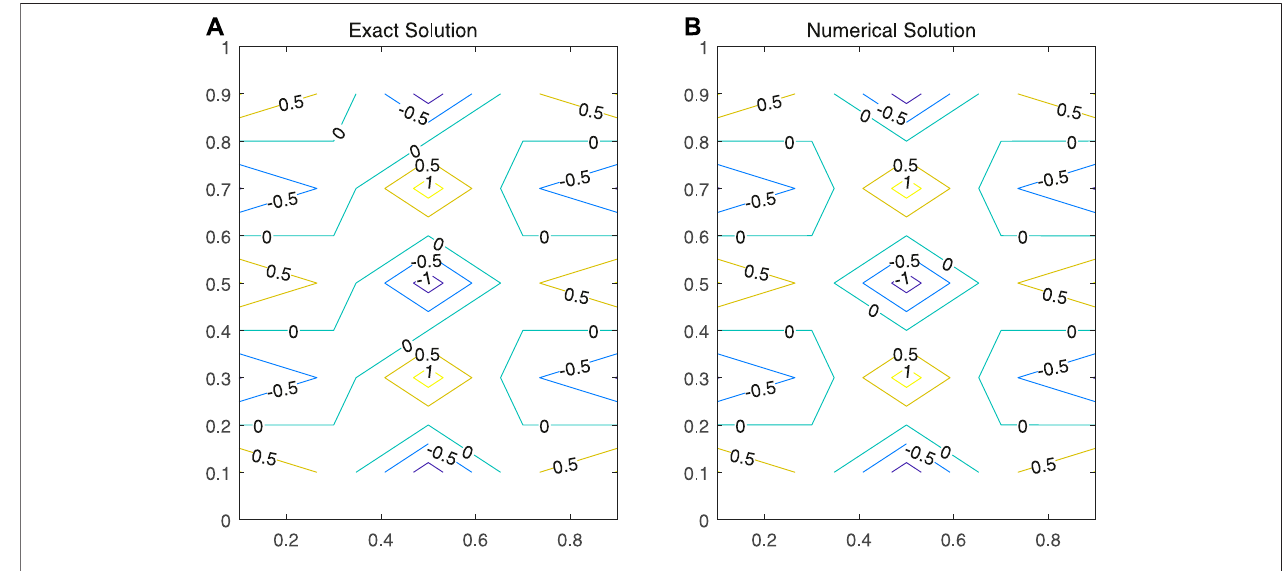
FIGURE 1 | Contour plot of exact solutions (A) and numerical solutions (B) .